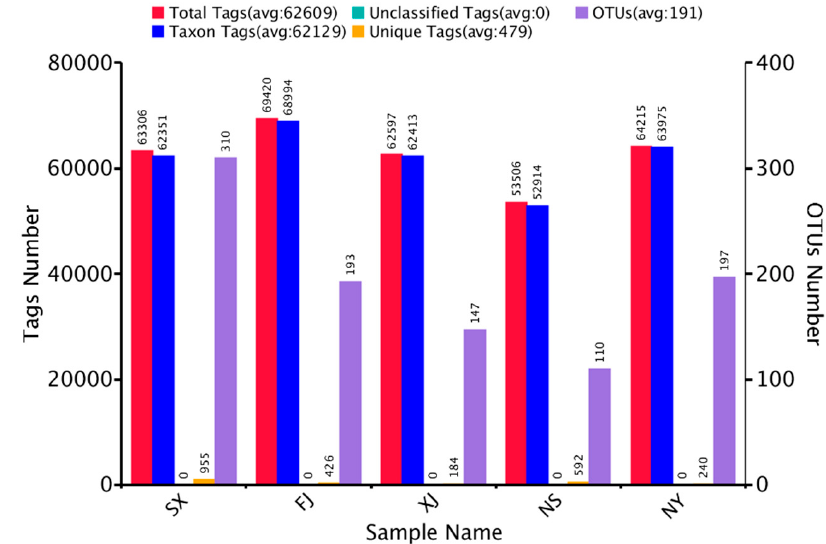
Figure 1. Operational taxonomic unit (OTU) clustering and annotation statistics of each sample.